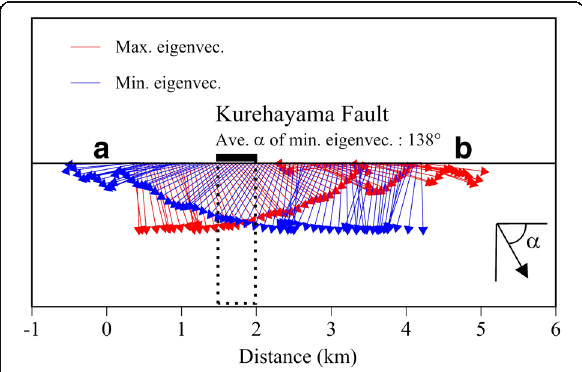
Fig. 10 Eigenvectors of the gravity gradient tensor on the profile shown in Fig. 7. The maximum eigenvector and minimum eigenvector are indicated by red and blue , respectively. The dips of eigenvectors are given clockwise from x -axis to z -axis. Since it is known that the Kurehayama Fault is a reverse fault, we focus on the minimum eigenvector of the tensor. The “ Kurehayama Fault ” shown in this figure indicates a tentative fault location in Toyama City (Toyama City 2013). The average dip of the minimum eigenvector in the Kurehayama Fault zone shown by a rectangle with dashed lines is about 138°, and this angle indicates that the Kurehayama Fault would be a reverse fault of 42°. In addition, the maximum eigenvectors on the right side of the “ Kurehayama Fault ” shown in this figure point to the vertical direction, and the minimum eigenvectors in the left side of the “ Kurehayama Fault ” point to the vertical